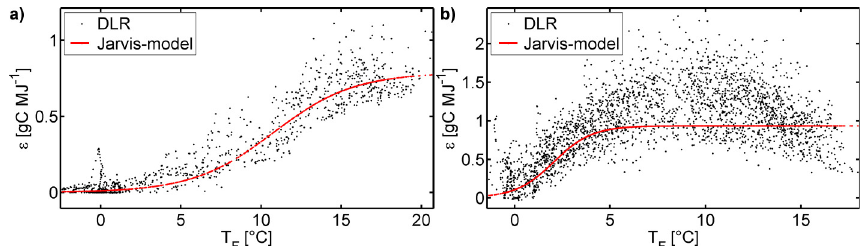
Fig. 2. (cid:15) obtained by DLR (see Eq. 2) as well as modelled according to Jarvis et al. (2004), both plotted vs. the delayed soil temperature T F . DLR is applied to estimate (cid:15) with the aim to better capture seasonal variations and reduce the impact of short term fluctuations by noise effects for diagnostic purposes. Panel (a) shows (cid:15) of the boreal deciduous forest Sylvania Wilderness with almost no decrease of (cid:15) for higher temperatures, whereas (b) represents a typical example of coniferous sites (Tharandt).